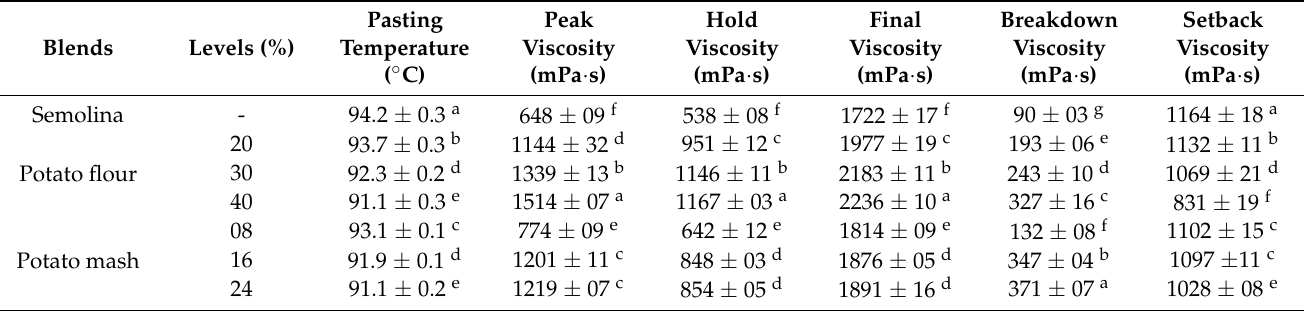
Table 1. Effect of replacing potato powder and mash with semolina on the pasting of pasta